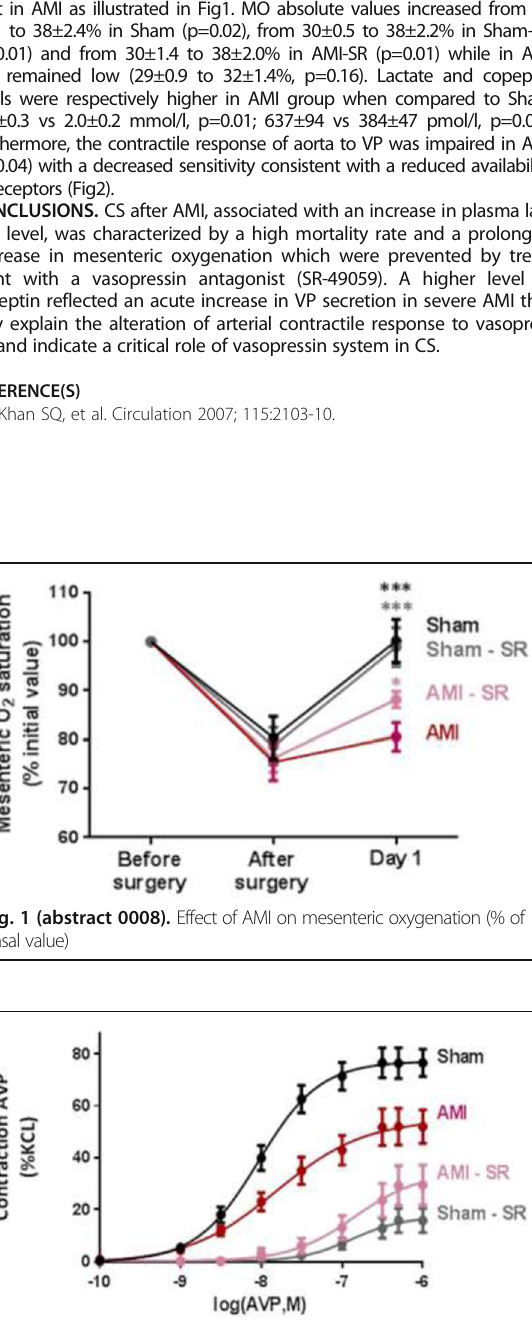
Fig. 2 (abstract 0008). Vasopressin-induced contractile response of aorta (% of maximal response to